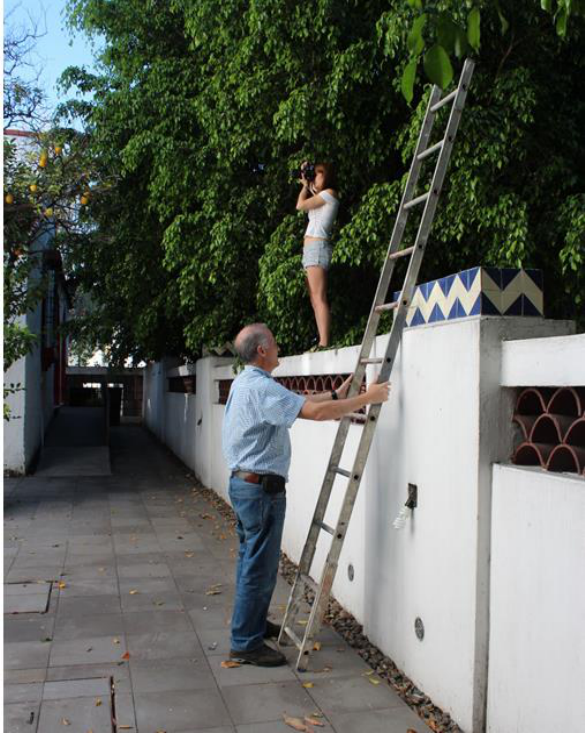
Fig. 9 Photos Capturing phase of the east façade for Photogrammetry. Photo’s author: Joel Becker. Photos of the south and east elevations were taken according to the photogrammetric rule (3x3), established by CIPA (ICOMOS CIPA, 2013), using photogrammetric strips with 60-80% of overlap. The photos were taken at an appropriate scale in order